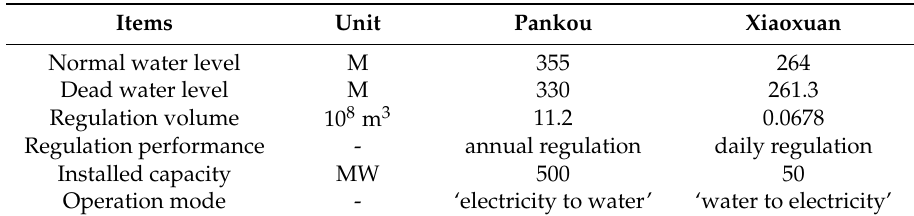
Table 3. Parameters of Pankou-Xiaoxuan cascade hydropower stations.